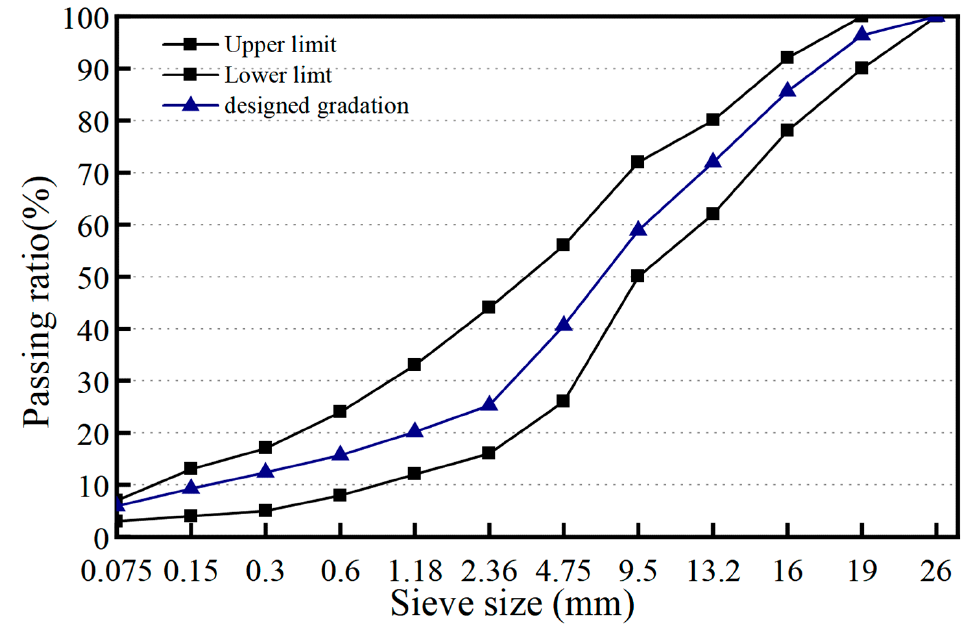
Figure 3. Aggregate gradation curve of AC-20.